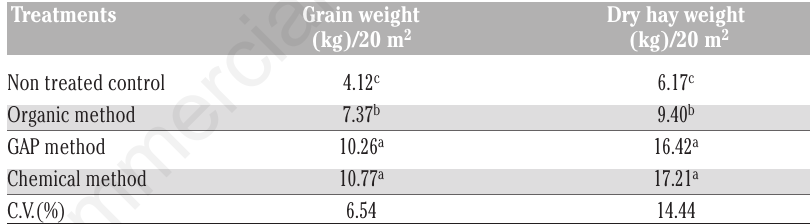
Table 5. Grain weight and dried hay weight of rice var. Sen Pidoa in the field trial at 80